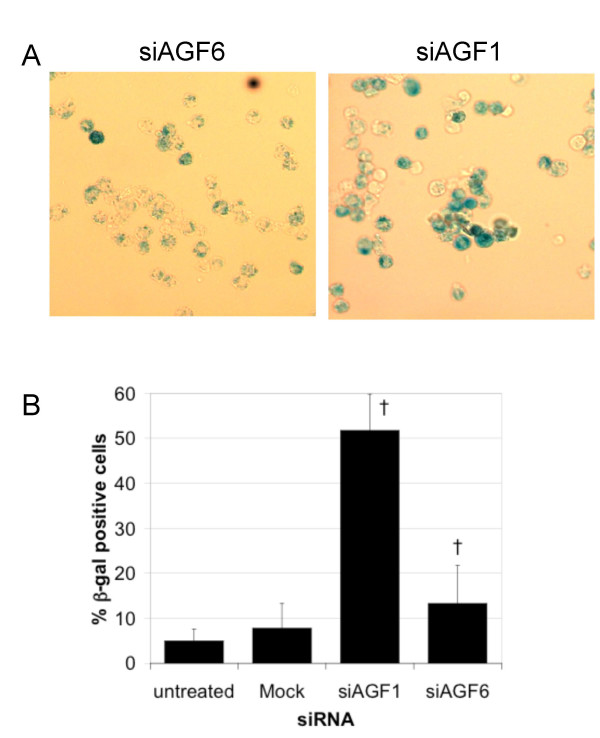
RUNX1-CBFA2T1 siRNAs induce senescence in Kasumi-1 cells A. Senescence-associated β-galactosidase stained cells. Kasumi-1 cells were electroporated with siRNAs at days 0 and 4, and were examined at day 8 for senescence by staining for senescence-associated β-galactosidase. B. Quantification of cellular senescence. Cells were treated as above, and the ratio of β-galactosidase positive cells was examined by counting. Error bars represent the standard deviations of single-blinded counts performed by three different experimentators. †, p < 0.01 according to Student's t-test